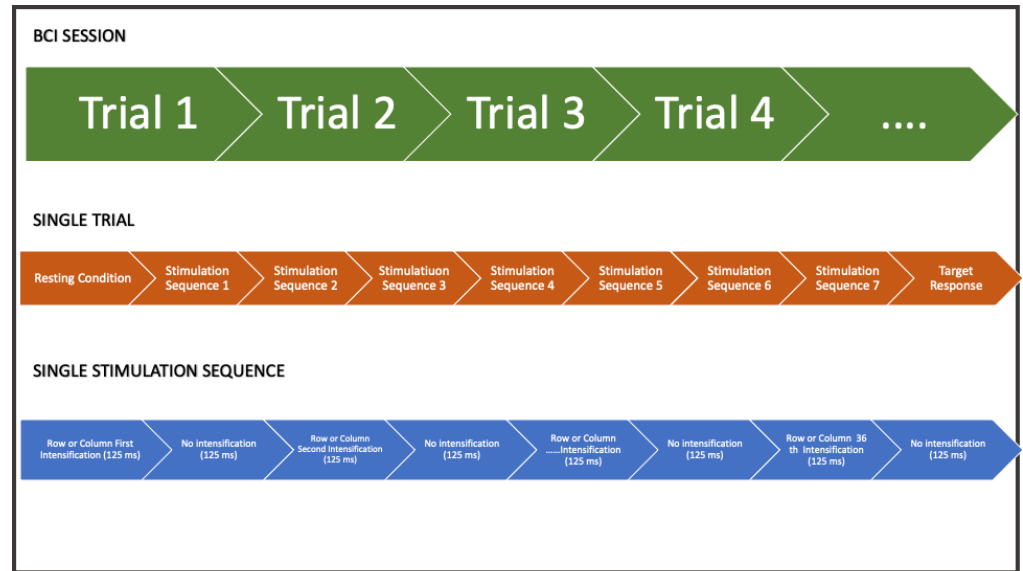
Figure 5. An example of timing duration of experimental protocol for single trial and all trials of the individual subject: a single BCI session is formed by a certain number of trials according to the user application. The user is stimulated with several stimulation sequences (for example, 7). In a single stimulation sequence, all rows and columns are intensified.